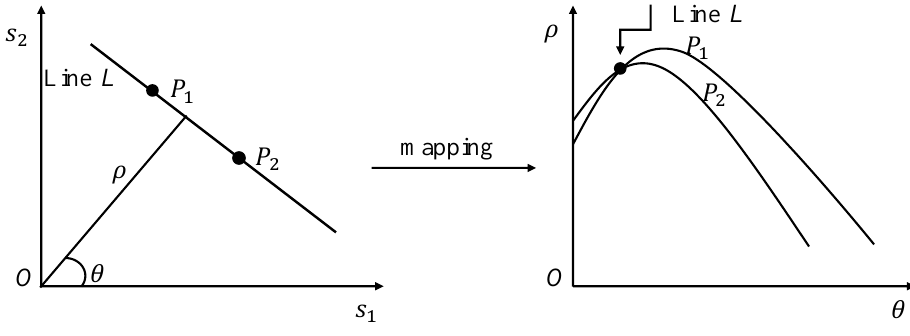
Figure 2. Mapping of 𝑃 1 and 𝑃 2 from Cartesian space to the (𝜌, 𝜃 ) parameter space.